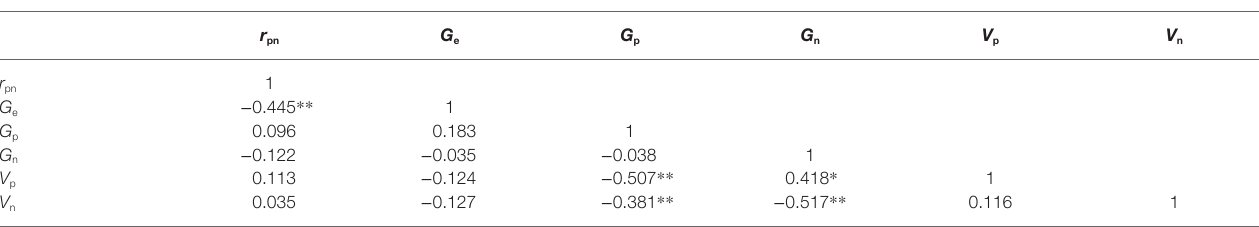
TABLE 4 | Associations between indicators of emotional complexity in Study 2.